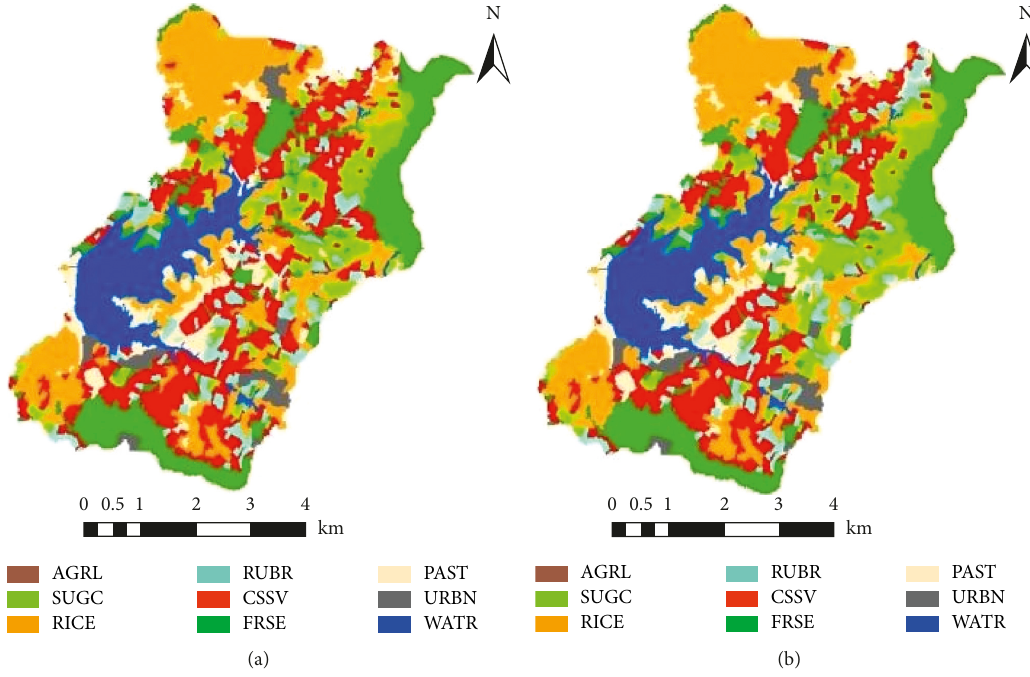
Figure 5: The validation results of actual land use (a) and simulated land use (b) for the Huay Sabag area.